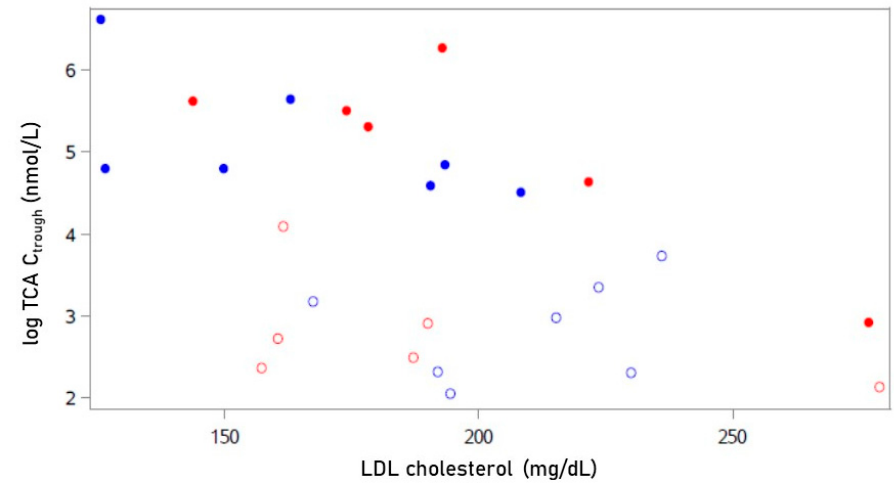
Figure 5. Correlation between taurocholic acid (TCA) trough concentrations and plasma LDL cholesterol at baseline (open circles) and after 12 weeks (closed circles) of treatment with bulevirtide (Spearman r = − 0.60; p = 0.03 for values after 12 weeks, closed circles). Participants with decrease of LDL cholesterol > 19.6 mg/dL in blue (“responder”); participants with no decrease and decrease < 19.6 mg/dL of LDL cholesterol in red (“non-responder”). The pharmacokinetic parameters of bulevirtide have been published separately